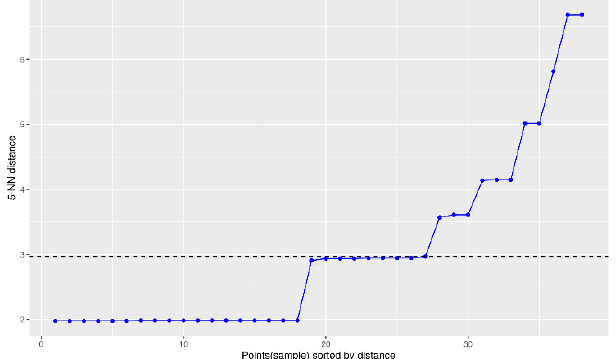
Figure 7. Elbow method in the DBSCAN algorithm.